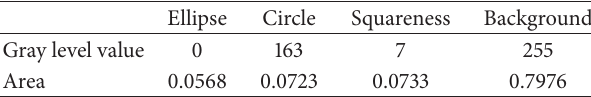
Table 1: The gray level values and areas of all